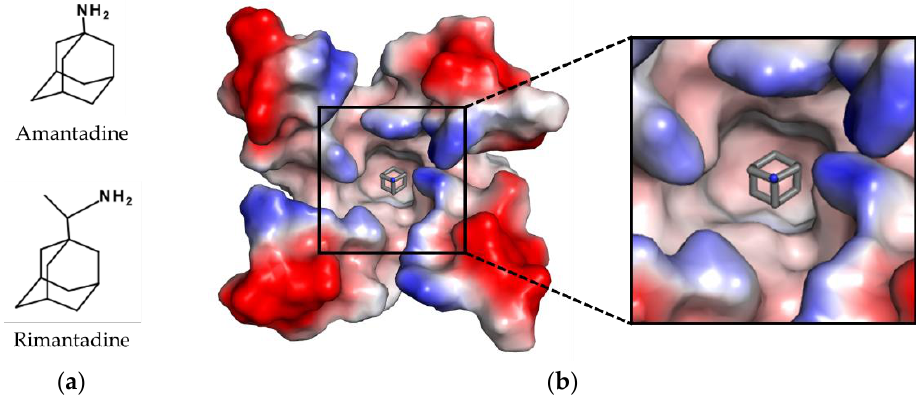
Figure 3. Structures of approved M2 channel inhibitors. ( a ) Chemical structure of amantadine and rimantadine. ( b ) Complex of amantadine (shown as sticks with grey carbon atoms and nitrogen in blue) in the pore of the M2 channel. The surface of the M2 channel was colored according to is calculated negative ( − 64 kT/e, red) and positive (+64 kT/e, blue) electrostatic potential. The structure was determined by X-ray crystallography (10.2210/pdb3C9J/pdb) [23]. The figure was generated with PyMOL Molecular Graphics System Version 2.0 (Schrödinger, LLC, New York, NY, USA).